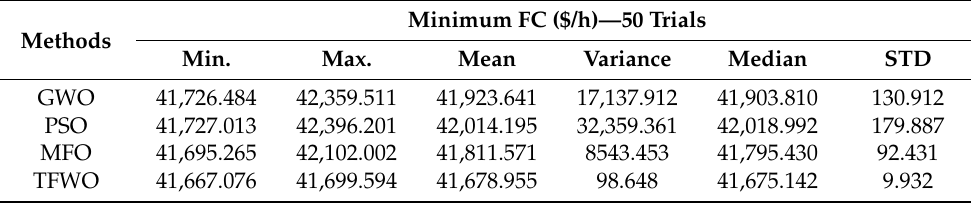
Table 10. Statistical performance evaluation of TFWO for Case 15 compared with three